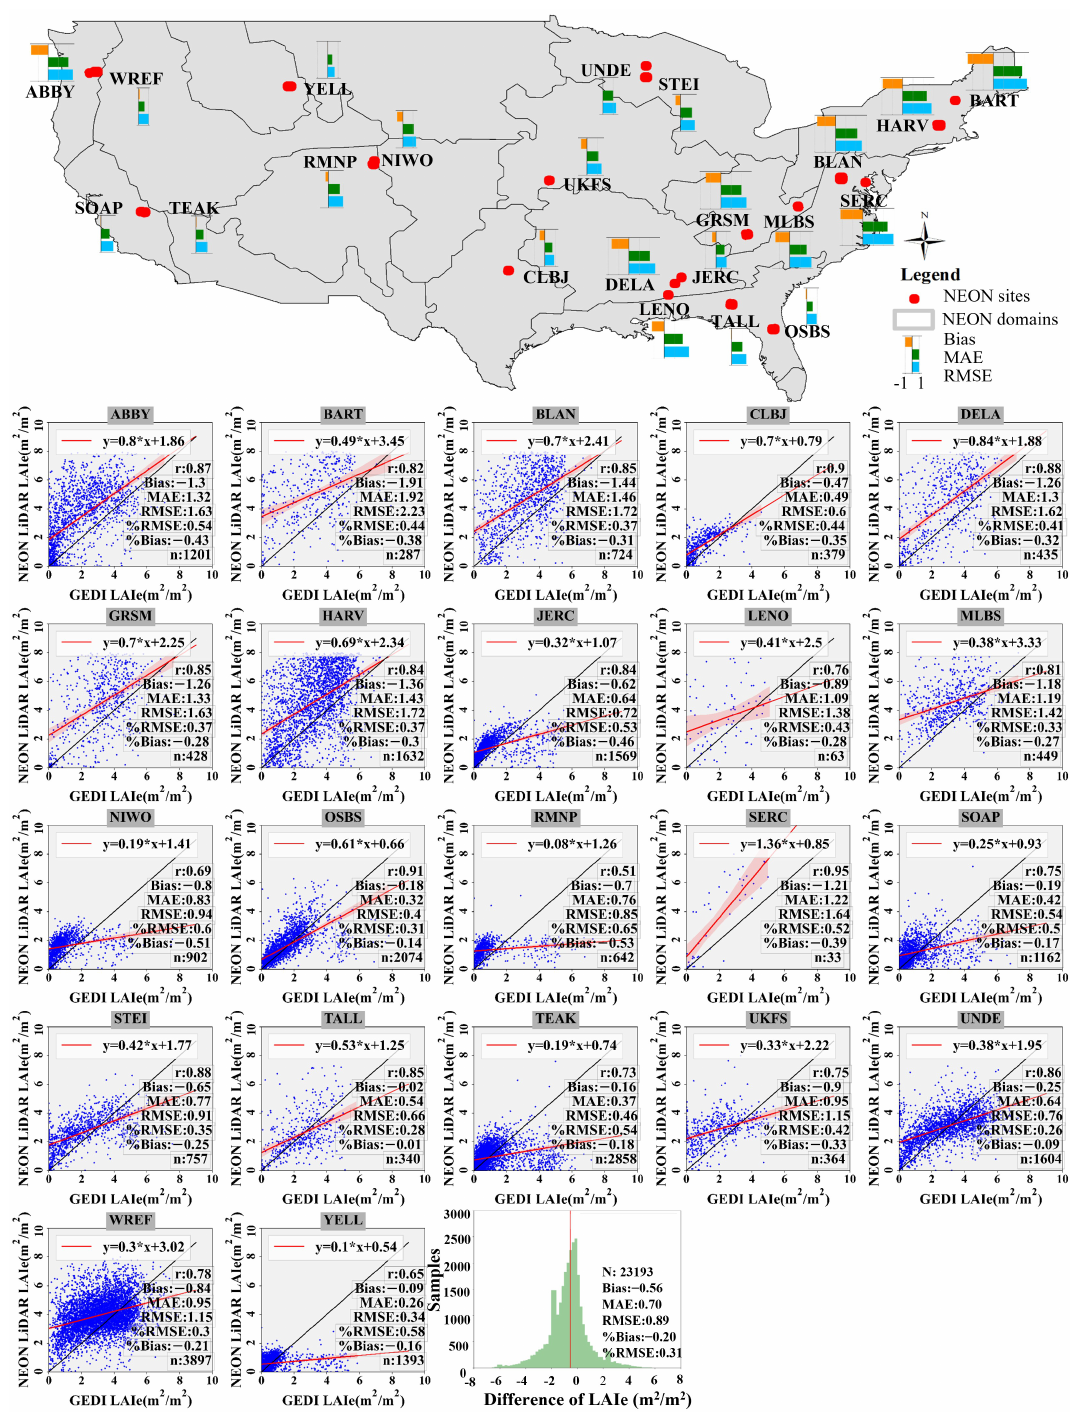
Figure 4. Comparison of LAIe between GEDI and NEON Lidar among the 22 NEON sites. The top map shows the spatial distribution of accuracy metrics among the NEON sites. The black and red solid lines in scatter plot are the 1:1 line and regression line, respectively. The scatter plots and histogram show the LAIe difference between GEDI and NEON Lidar, respectively. Each scatter plot represented a NEON site with its name marked in the gray